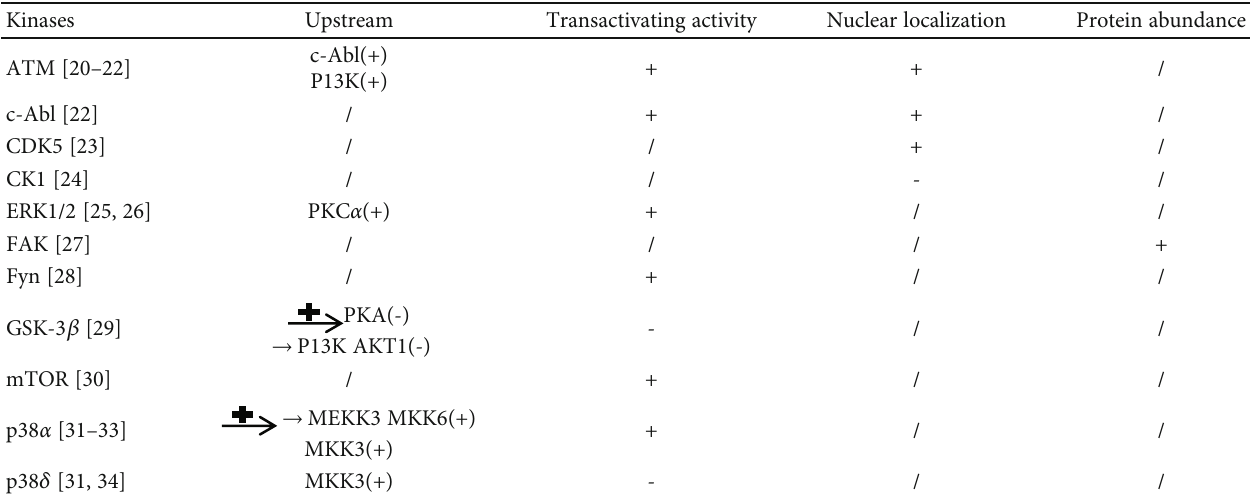
Table 2: List of major kinases to regulate tonicity-dependent activation/inactivation of NFAT5. Kinases Upstream